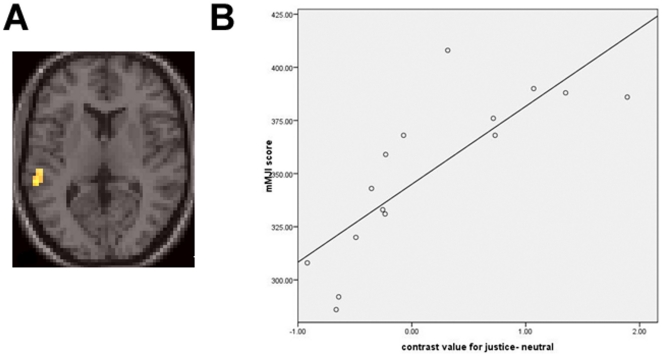
Participants' modified Moral Judgment Interview (mMJI) scores showed positive correlation with the extent of left posterior superior temporal sulcus (pSTS) activation in the justice-neutral contrast (A), and illustrated in B for a spherical volume (5 mm radius) centered on.−54, −39, 8 mm; r2 = 0.648, p<0.0001. k = >5).